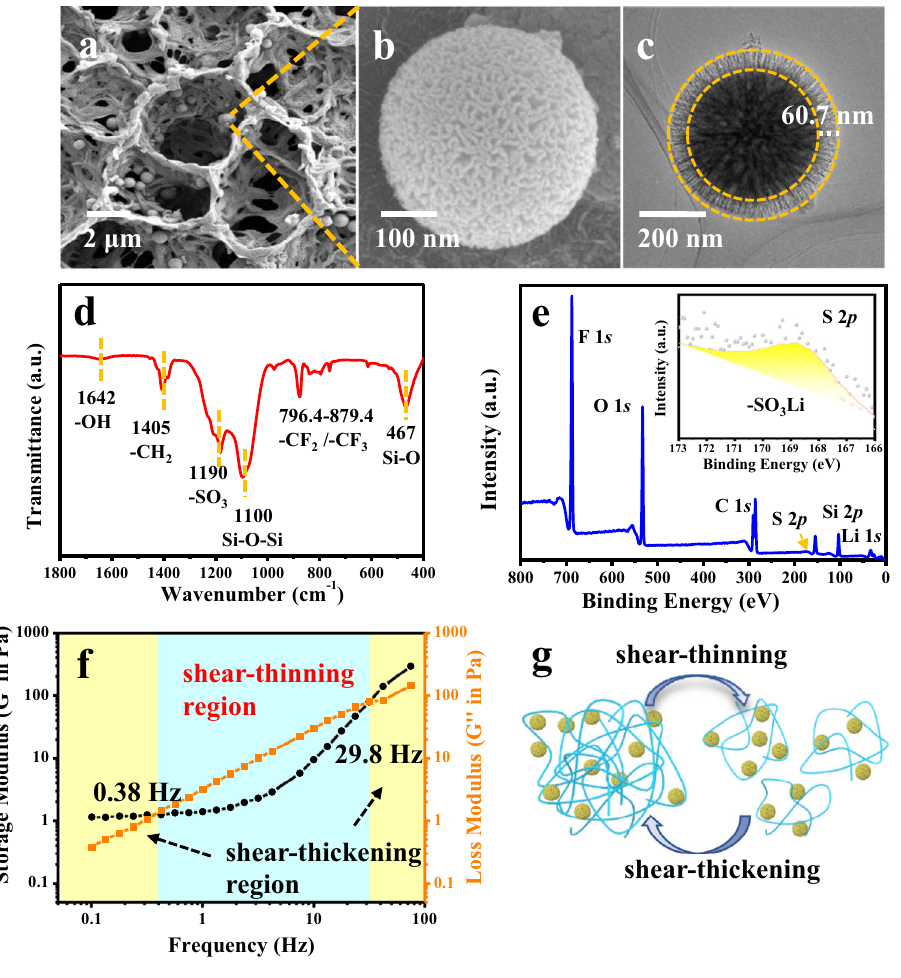
Fig. 2 | Characterization of SiO 2 -SO 3 Li/PVDF-HFP quasi-solid electrolyte. a , b SEM analysis; c TEM analysis of the SiO 2 -SO 3 Li particles; d FTIR spectra; e XPS full spectrum and S 2 p spectra; f Rheological analysis of NNFQSE; g Shear-